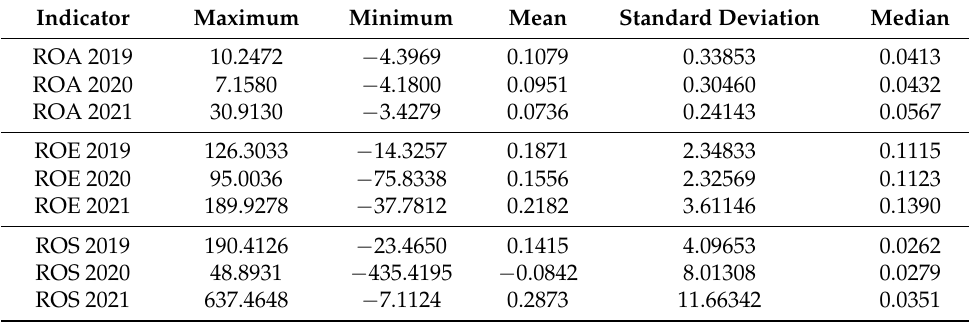
Table 4. Descriptive statistics for large companies. Source: own research. Indicator